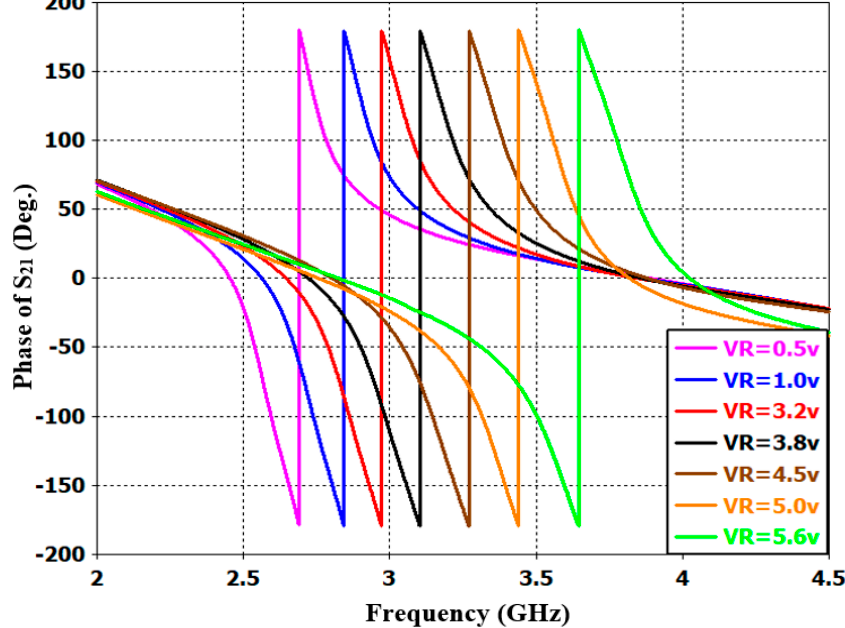
Figure 18. Simulated phase characteristics of S 21 with different DC reverse bias voltages for the presented reconfigurable microstrip BPF.